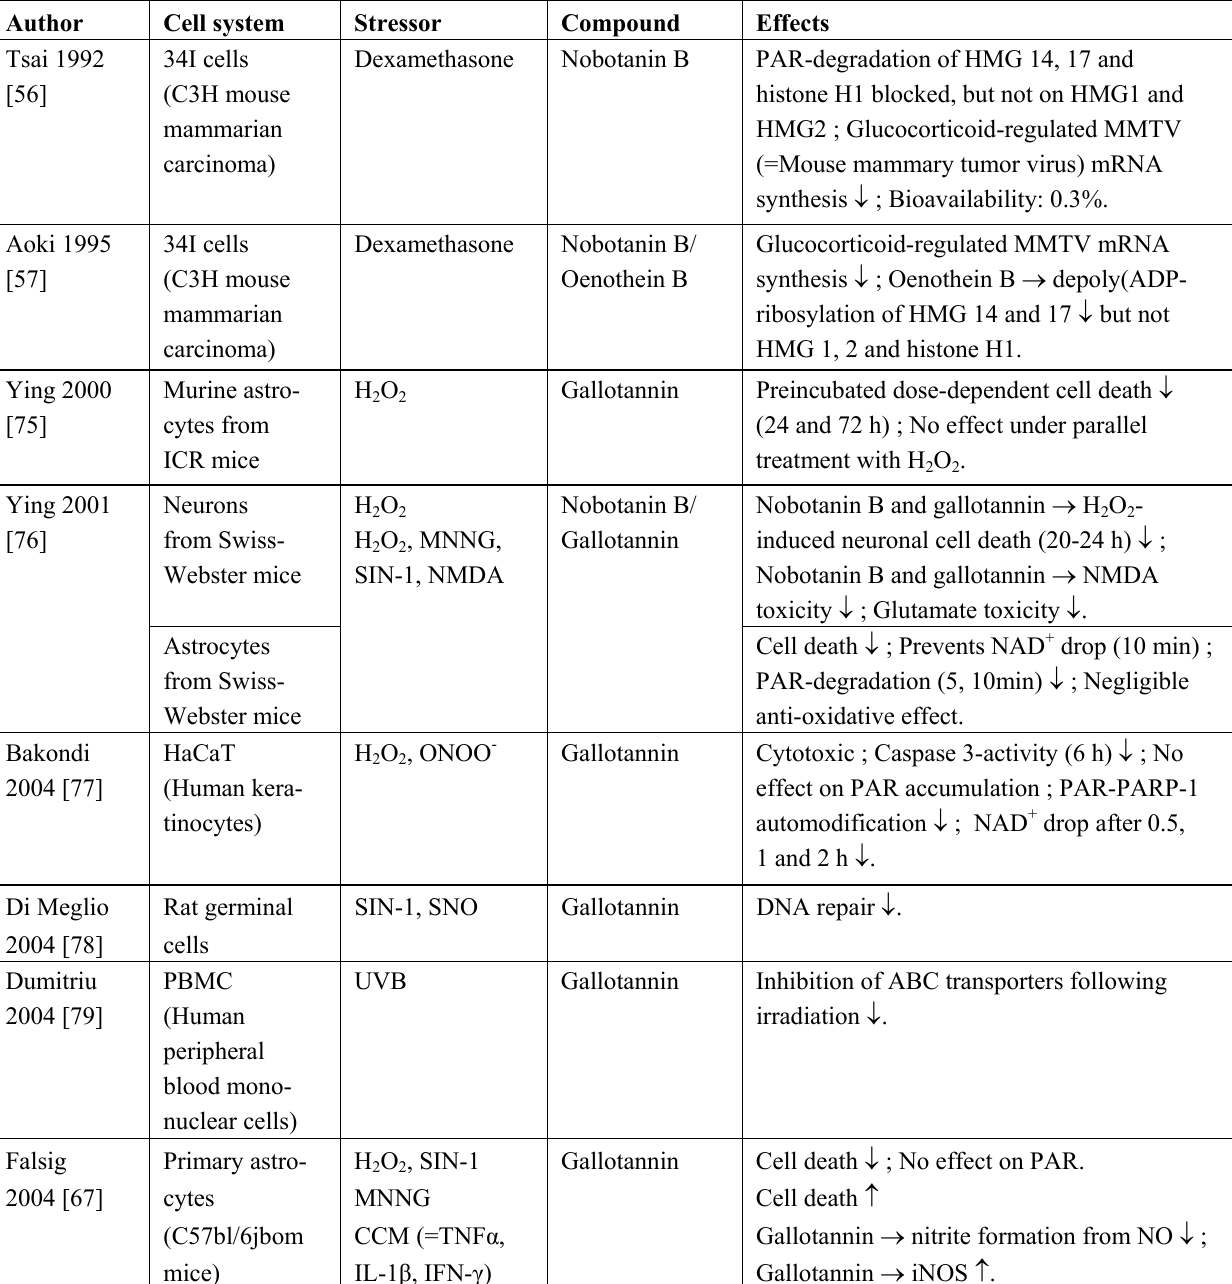
Table 2. Tannin derivatives as PARG inhibitor in cell culture